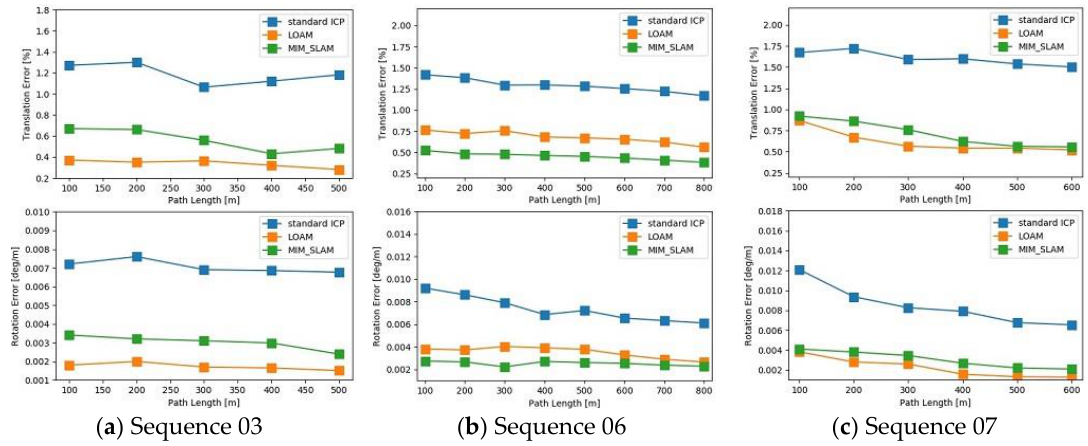
Figure 12. The pose estimation error in the three sequences.